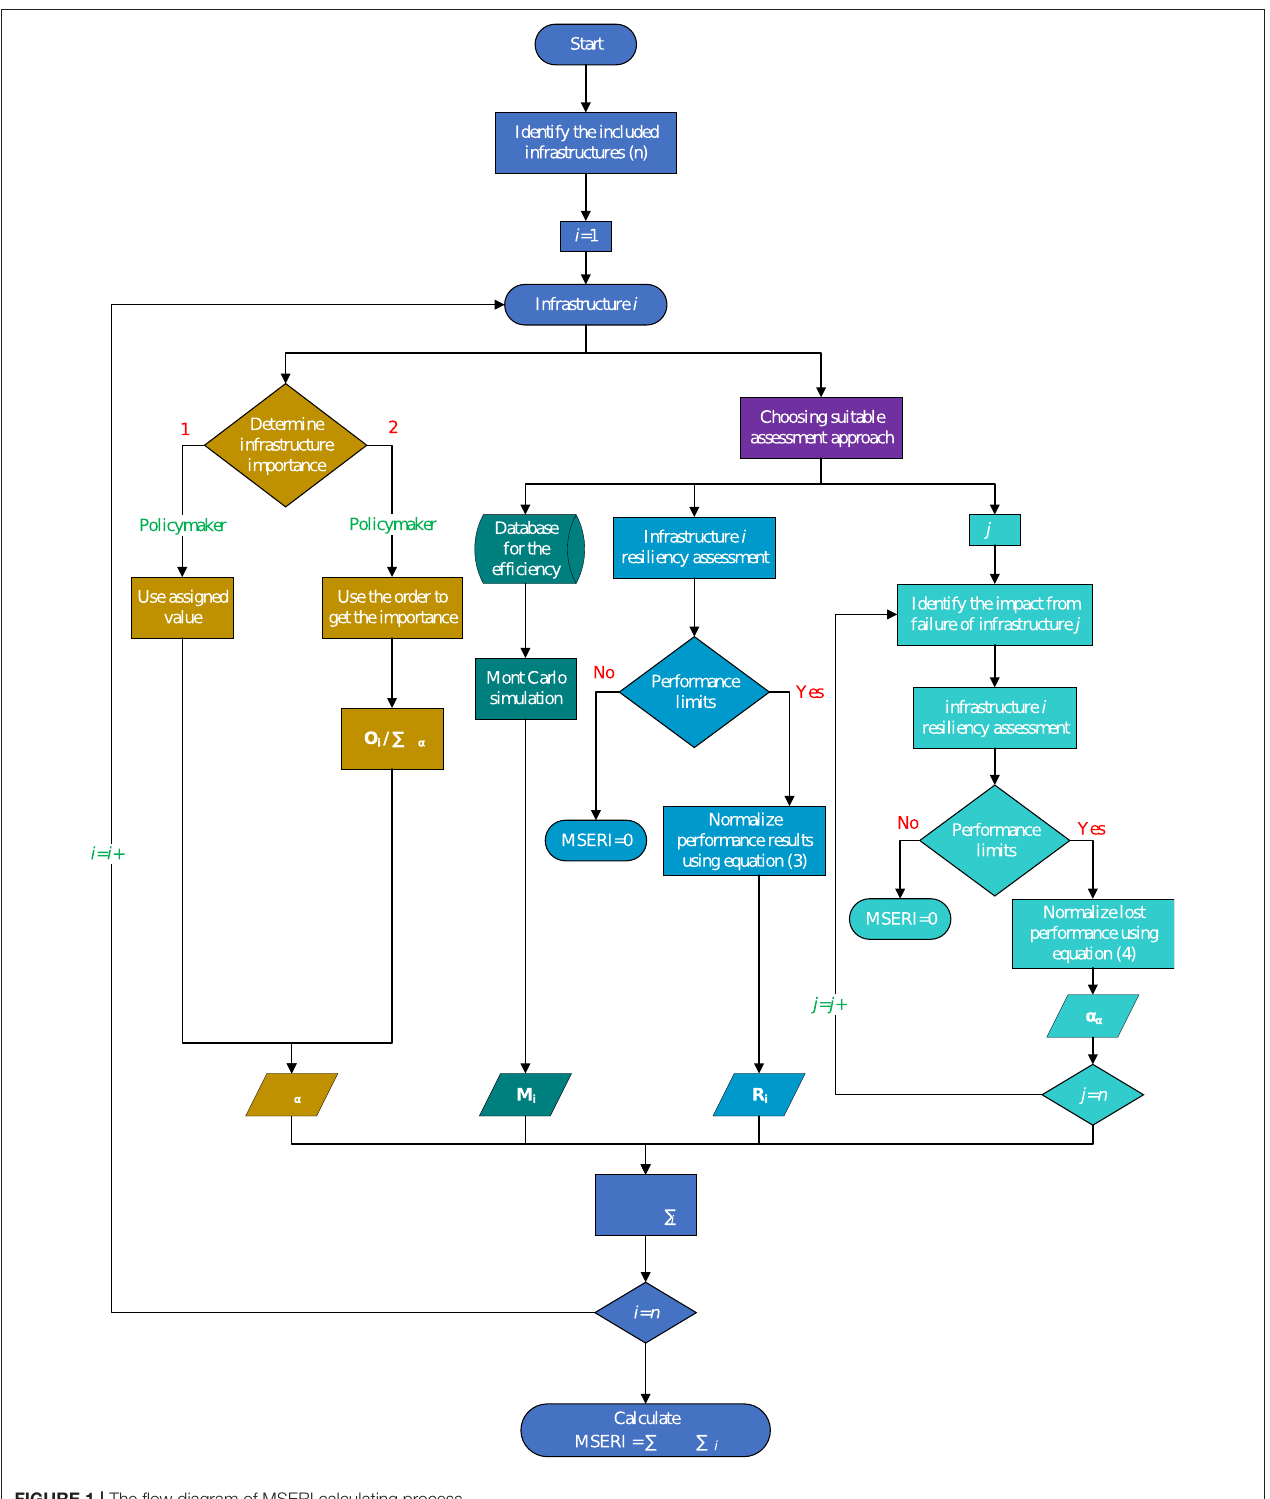
FIGURE 1 | The flow diagram of MSERI calculating process.